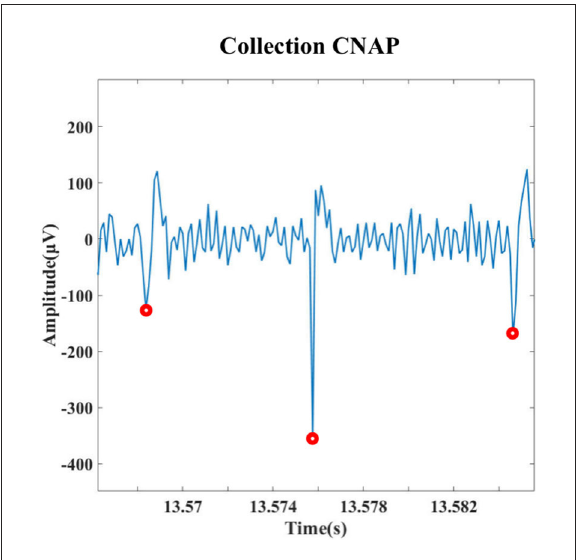
FIGURE9 Detection results for spike signal in vivo experiments on